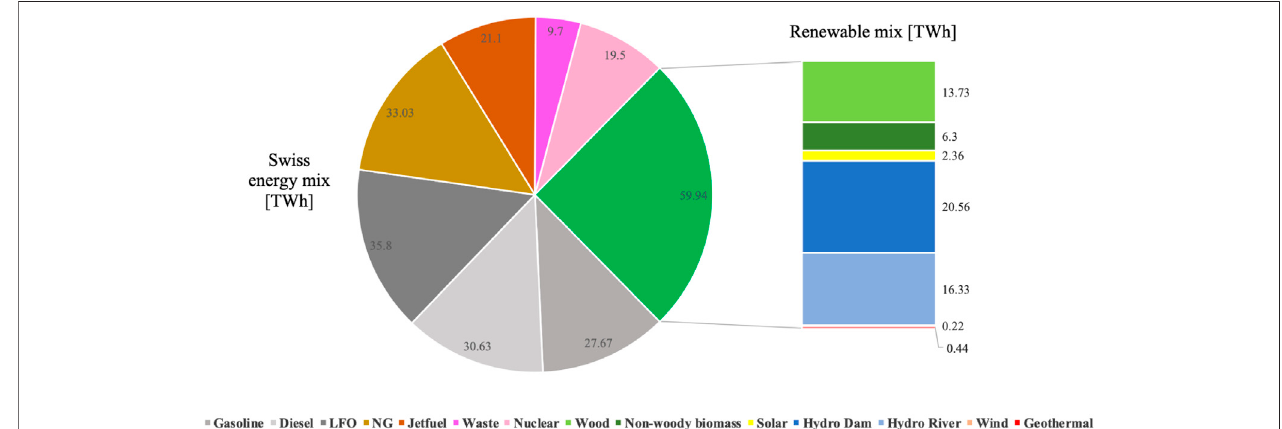
FIGURE 5 | Swiss fi nal energy consumption in 2017.